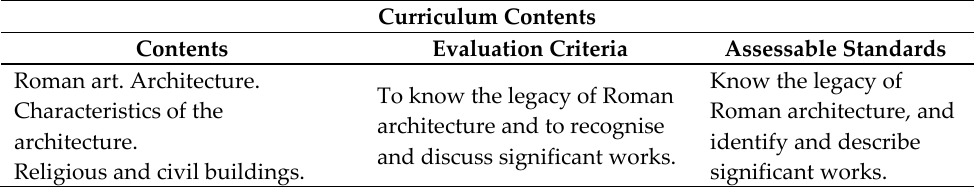
Table 1. Curriculum contents referring to Greek and Roman architecture: Source: decree